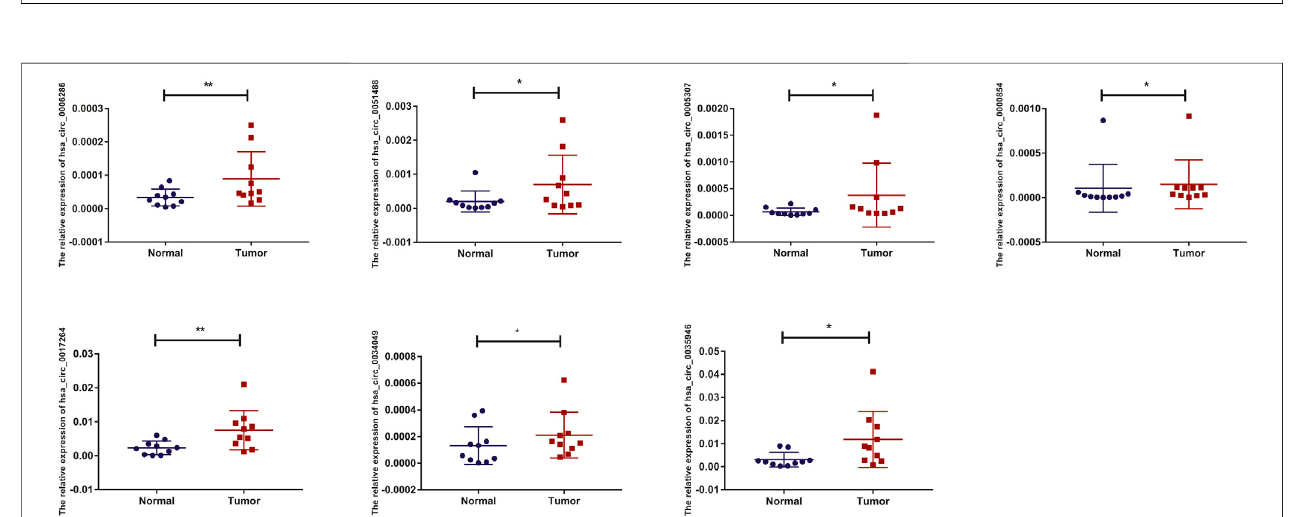
FIGURE 3 | qRT – PCR validation of the expression of candidate circRNAs in LIHC tissues and adjacent normal tissues ( n = 10).